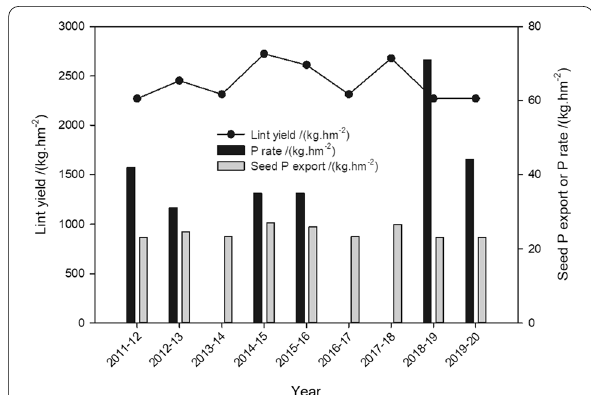
Fig. 2 Average lint yield (Cotton Year Book, 2011 to 2020), P fertiliser use (CRDC-Annual cotton grower surveys, 2011–2012 to 2019–2020)